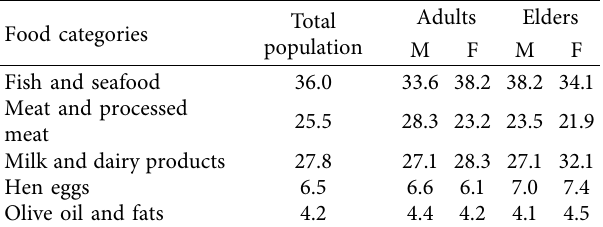
Table 4: Percentage of contribution (%) from each food categoriy to the total dietary intake of iPCBs for the total population and for adults (18–64.9 years) and elderly ( ≥ 65